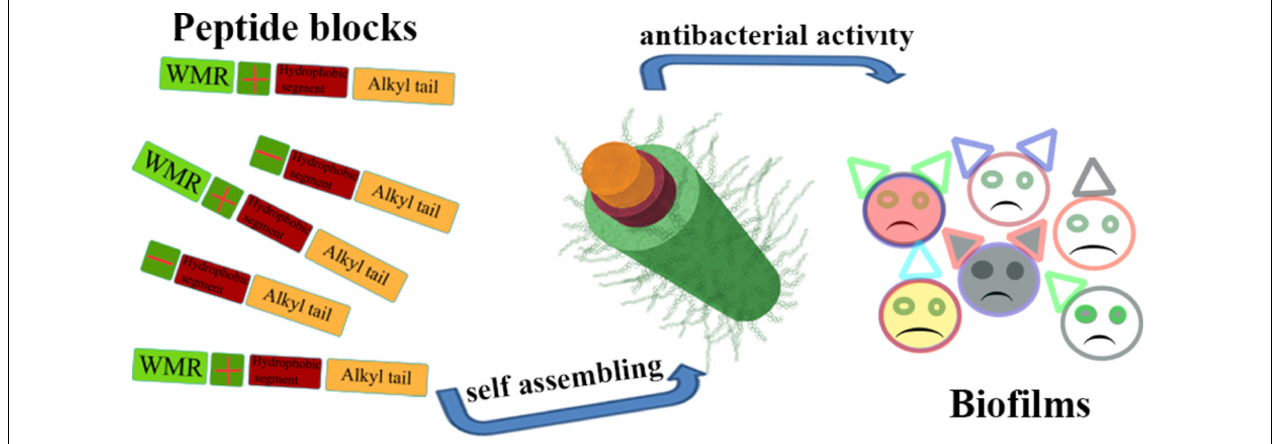
FIGURE 8 | Illustration of the nanostructure of lipopeptide and its special function (Lombardi et al., 2019b). Copyright 2019, American Chemical